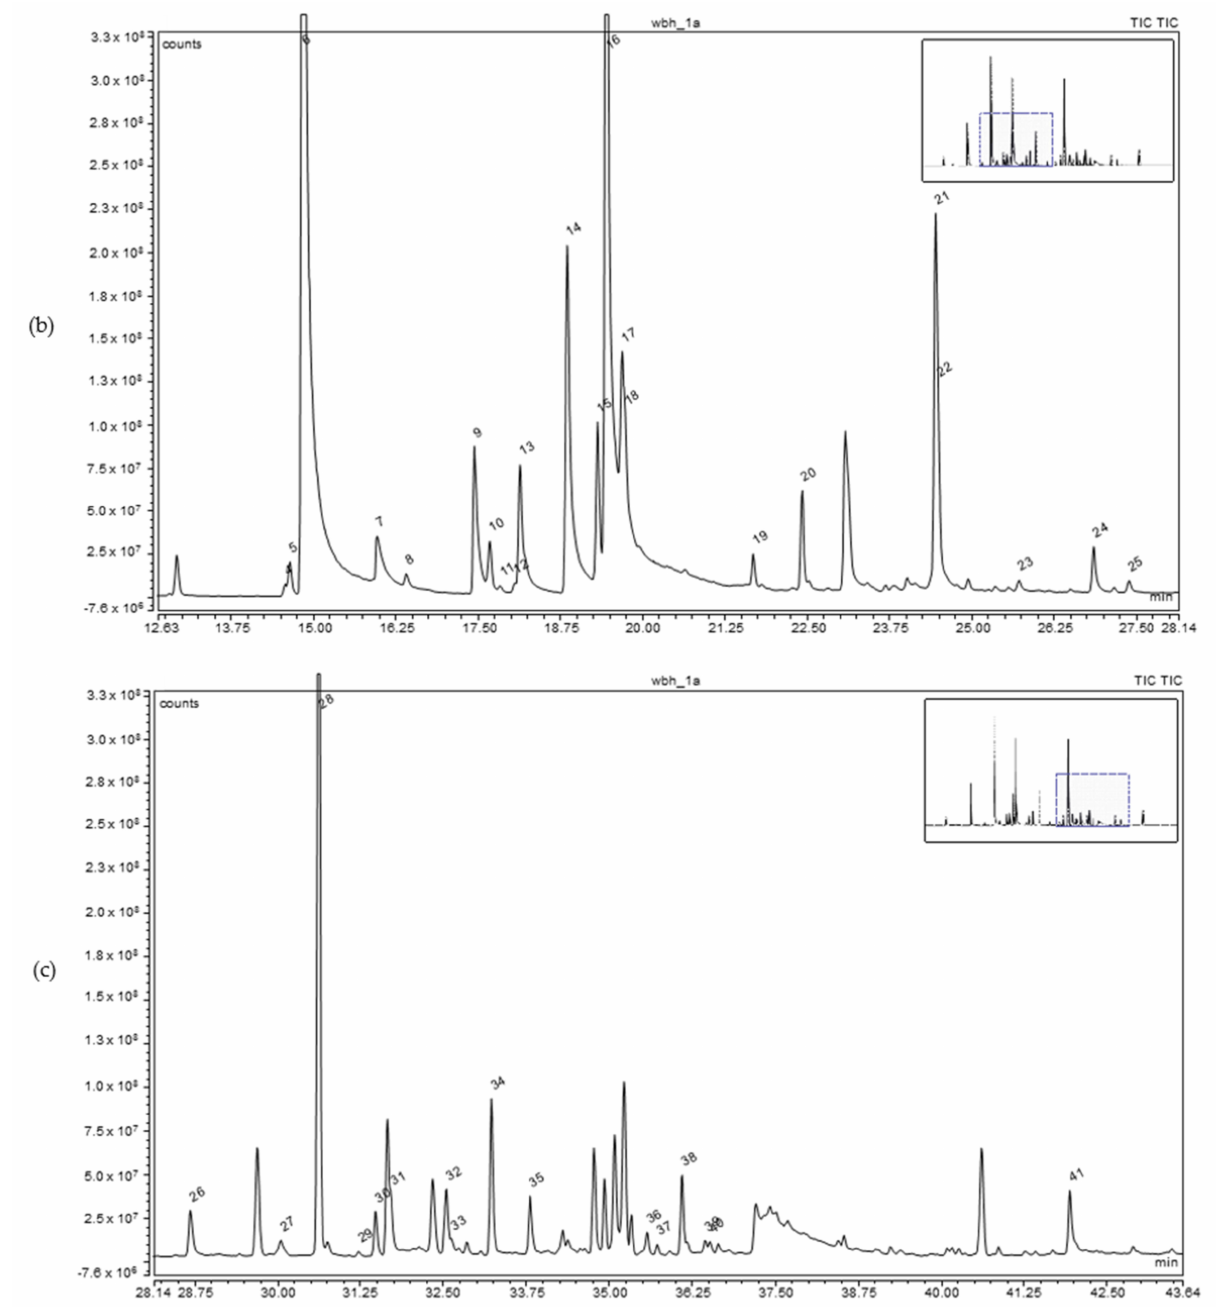
Figure A3. Total ion chromatogram of volatile analysis with HS-SPME-GC-MS from enzymatically extracted oil (Neutrase, 35 min) from whole Baltic herring. ( a ) Total ion chromatogram, ( b ) chromatogram scaled to retention time 12.63–28.14 min and ( c ) chromatogram scaled to retention time 28.14–43.64 min. The numbered volatiles are (1) acetaldehyde, (2) 2- propenal, (3) propanal, (4) butanal, (5) 2,3-butanedione, (6) unknown 1, (7) formic acid, (8) 1,3-butanediol, (9) acetic acid, (10) 3-methylbutanal, (11) heptane, (12) 2-methylbutanal, (13) ( Z )-2-butenal, (14) 2-ethylfuran, (15) 1-penten-3- one, (16) 1-penten-3-ol, (17) 2,3-pentanedione, (18) cyclopentanol, (19) propanoic acid, (20) ( E )-2-pentenal, (21) hexanal, (22) 2-methyl-4-pentenal, (23) 3-hexanol, (24) 2,4-hexadien-1-ol, (25) ( E )-2-hexenal, (26) heptanal, (27) ( E , E )-2,4-hexadienal, (28) unknown 2, (29) 2-pentylfuran, (30) ( Z )-2-heptenal, (31) trans-2-(2-pentenyl)furan, (32) octanal, (33) hexanoic acid, (34) ( E , Z )-2,4-heptadienal, (35) ( E , E )-2,4-heptadienal, (36) ( E , E )-3,5-octadien-2-one, (37) 2-nonanone, (38) nonanal, (39) 5- ethyl-2(5H)-furanone, (40) ( E , E )-3,5-Octadien-2-one and (41) nonanoic